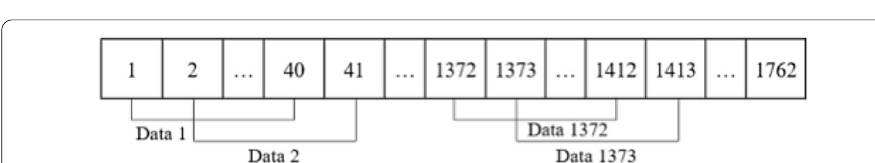
Fig. 10 Illustration of the data